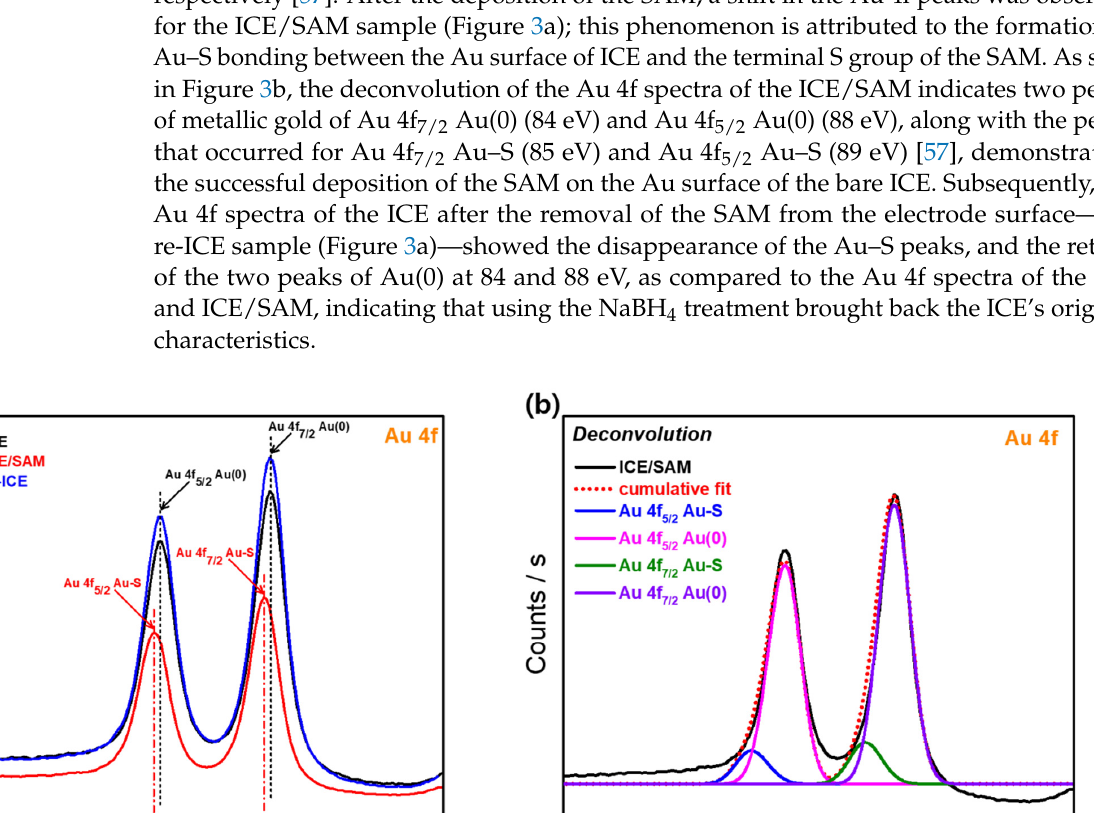
Figure 4. FT ‐ IR results of the ICE, ICE/SAM, and re ‐ ICE. 3.2. Electrochemical Characterization of the ICE, ICE/SAM, and Re ‐ ICE, and the Application of Re ‐ ICE for the Deposition of the SAM on the Electrode Surface The EIS tests of ICE, ICE/SAM, re ‐ ICE, and re ‐ ICE/SAM were performed in 1 mM K[Fe(CN) 6 ] 3 − /4 − containing 0.1 M KCl, and results are expressed through Nyquist plots, as shown in Figure 5a–c. Using REC to fit the EIS data, the values of the three parameters of R ct , C dl , and R s were obtained, and are displayed in Table 1. The fitted R ct value of the ICE was 86 k Ω . Significant enhancement in R ct was observed after the addition of the SAM to